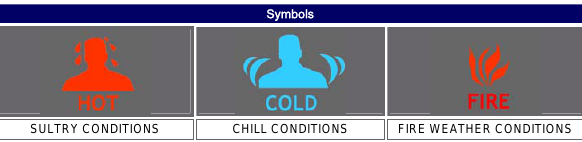
alerts. Table 3. The symbols of the human discomfort and the fire weather